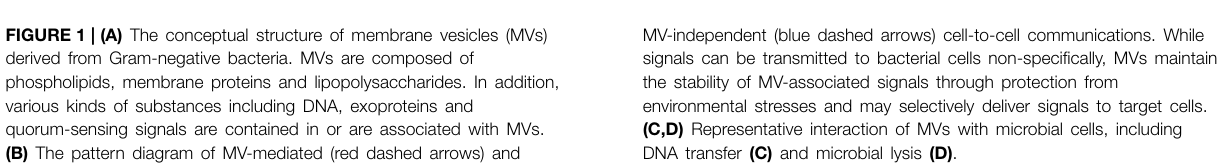
MV-independent (blue dashed arrows) cell-to-cell communications. While signals can be transmitted to bacterial cells non-specifically, MVs maintain the stability of MV-associated signals through protection from environmental stresses and may selectively deliver signals to target cells. (C,D) Representative interaction of MVs with microbial cells, including DNA transfer (C) and microbial lysis (D)